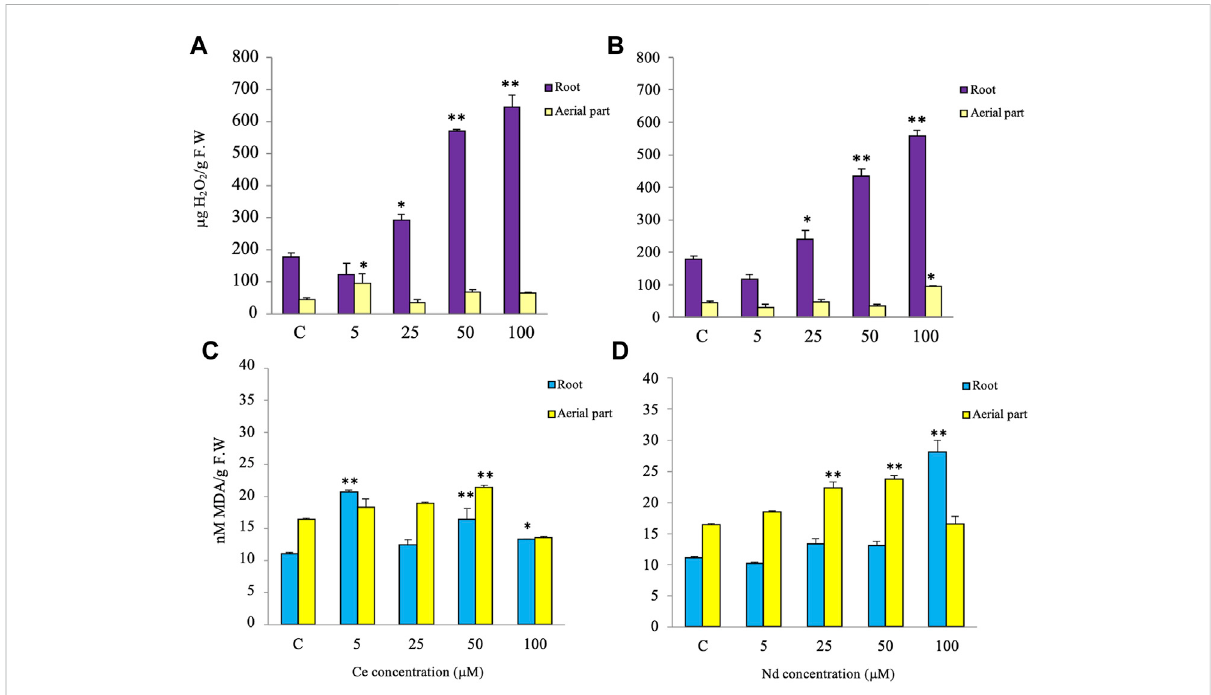
FIGURE 4 EffectsofdifferentCeandNdconcentrationsonthehydrogenperoxide(H 2 O 2 ) (A,B) andmalondialdehyde(MDA) (C,D) contentsafter3 daysof treatment in roots and aerial parts of lentils. Vertical bars indicate the SD of three replicates in each treatment group. * Statistical signi fi cance at p < 0.01 (*), p < 0.001 (**), and p < 0.0001 (***). F.W, fresh